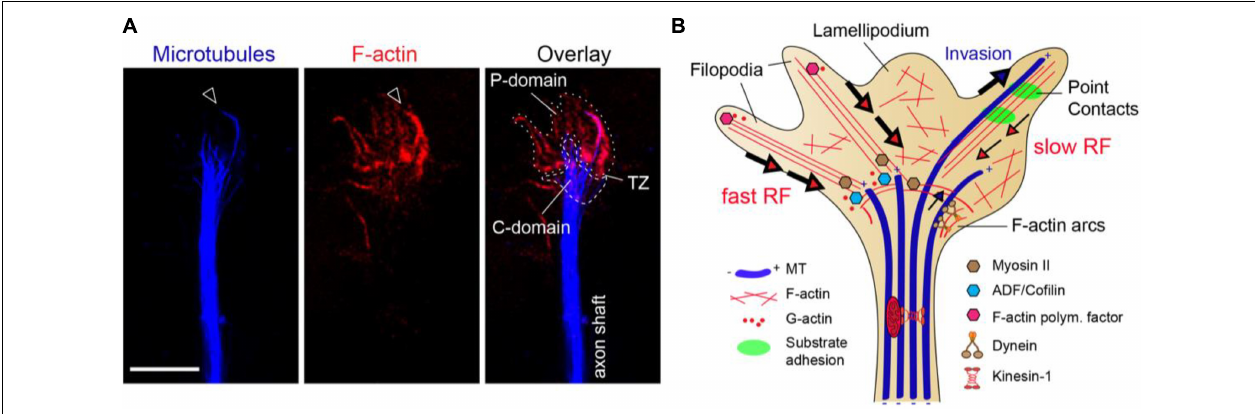
FIGURE 1 | The growth cone cytoskeleton. (A) High-resolution image of an axonal growth cone labeled with phalloidin (red) and α -tubulin (blue) from a hippocampal neuron culture. Actin filaments (F-actin) and microtubules (MTs) are segregated amid the peripheral (P-domain) and central regions (C-domain), respectively. Arrowhead marks isolated MTs invading the P-domain aligned with F-actin bundles. P-domain and C-domain are outlined using a dotted or dashed lines, respectively. TZ, transition zone. Scale bar, 5 µ m. (B) The clutch model for growth cone protrusion and steering. F-actin (red lines), microtubules (blue thick tubes), MT plus-ends (+), point contacts of adhesion (green). Filopodia is formed by F-actin bundles and lamellipodia by F-actin meshworks. The F-actin retrograde flow at the P-domain is balanced between F-actin polymerization and depolymerization rates, and myosin-based pulling forces at the TZ. Actomyosin forces at the TZ restrain MT entry into the P-domain. The engagement of F-actin to adhesion point contacts slows the F-actin retrograde flow rate and facilitates MT invasion to the growth cone periphery, determining outgrowth and